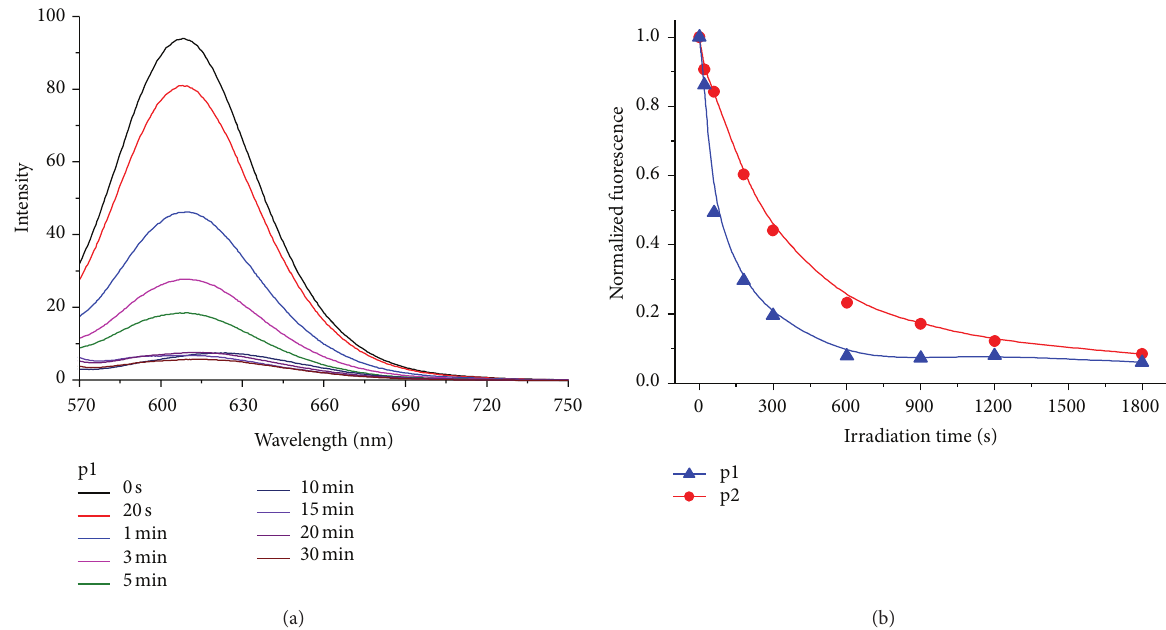
Figure 5: (a) Evolution of fluorescence emission spectra ( 𝜆 = 550 nm) of NR loaded PEO- b -P(NIPAM- co -NBA) diblock copolymer ex micelles under various UV irradiation time (2000 mW/cm 2 ; 0.8 mg/mL, 2 mL); (b) plots of normalized fluorescence intensity versus UV light irradiation time for the NR loaded micelles of the two block copolymers in aqueous solution.